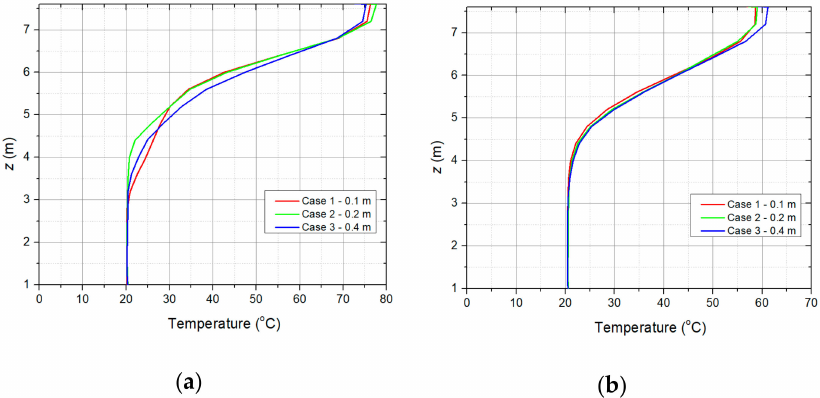
Figure 5. The vertical temperature distribution: ( a ) Location A ( Y = 120) and ( b ) Location B ( Y =